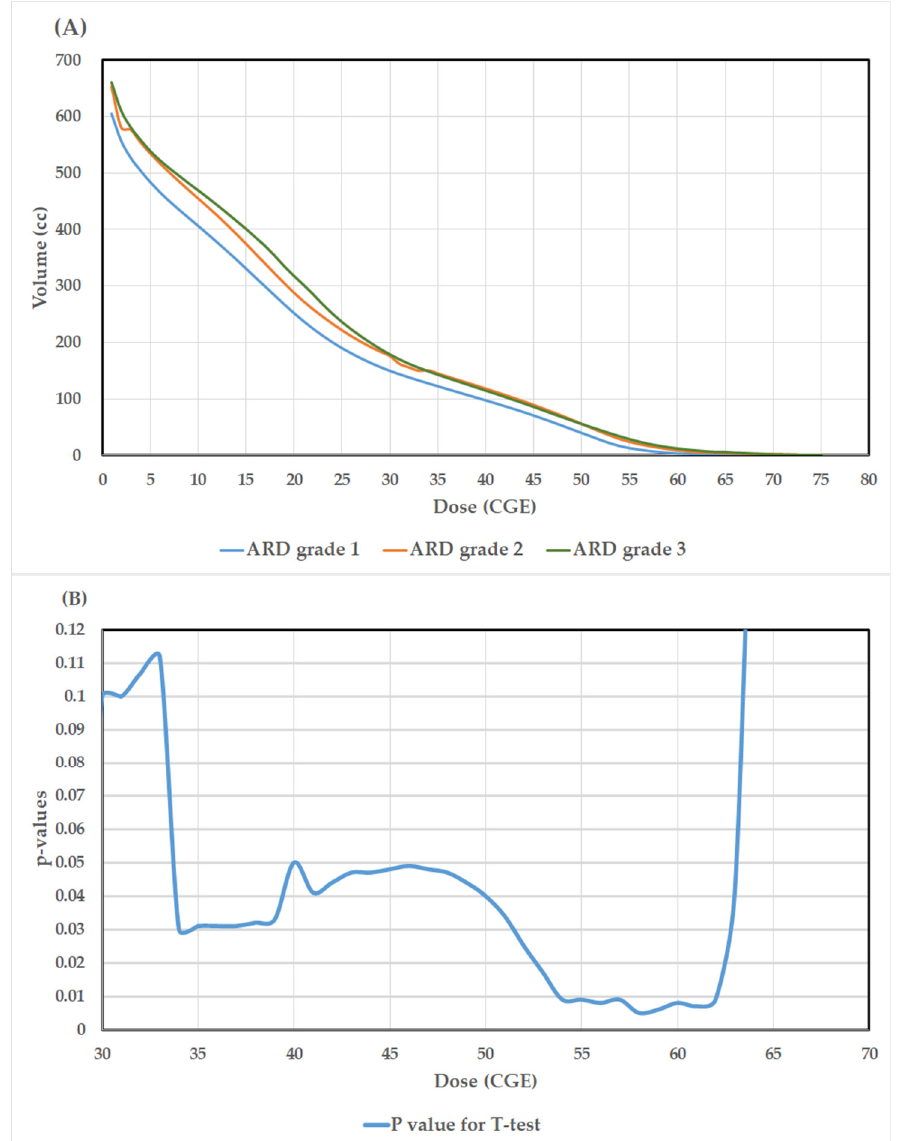
Figure 2. ( A ). The average volumes to skin 5 mm with the respective doses referring to patients experiencing grade 1, grade 2, and grade 3 acute radiation dermatitis (ARD); ( B ). Results of the p -values (two-tailed t-test) for the differences of average volume to skin 5 mm with the respective doses between those with grade 1 versus grade 2 and 3 ARD.